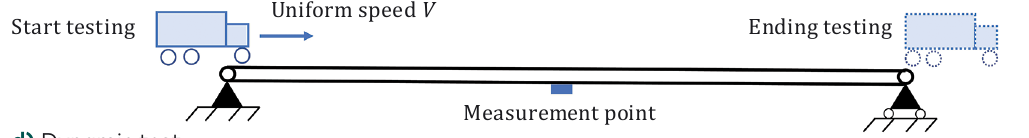
Figure 2. Photos of IBIS instrument and the loading truck and schematic diagram of loading